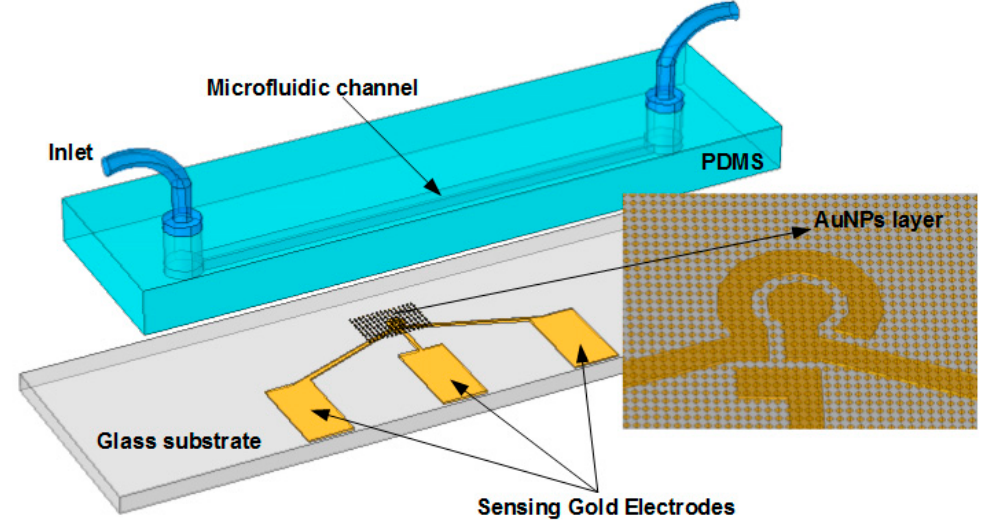
Figure 1. Schematic of the microfluidic device, including a glass substrate, a gold microelectrodes pattern and a polydimethylsiloxane (PDMS) channel. A self-assembled monolayer (SAM) of gold nanoparticles (AuNPs) was deposited to the location of the electrodes. The electrodes were used to identify the region of SAM, and the main binding events of the immobilization process. Aptamers were then conjugated onto the AuNPs layer to capture target cells in the microfluidic channel.